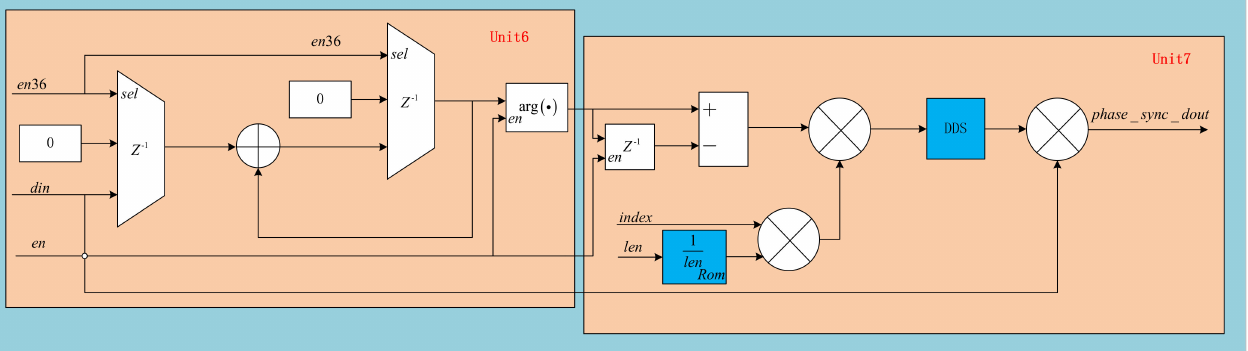
Figure 8. Block diagram of CPR